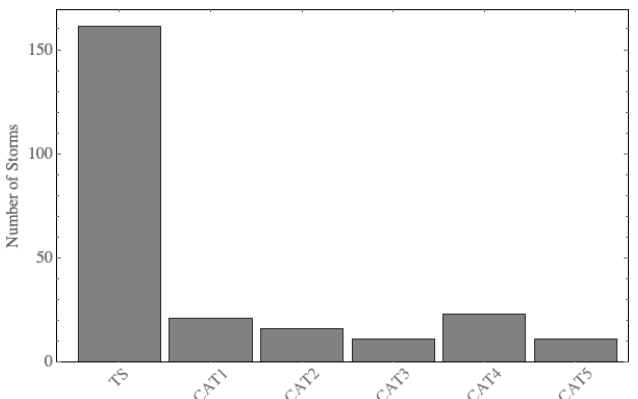
Figure 10. Division of the storm strengths that were evaluated by P-CLIPER within the 350 km radius of the North Carolina area. Abbreviations in figure are as follows: TS—Tropical storm, CAT1—Category I, CAT2—Category 2, CAT3—Category 3, CAT4—Category 4, CAT5—Category 5.